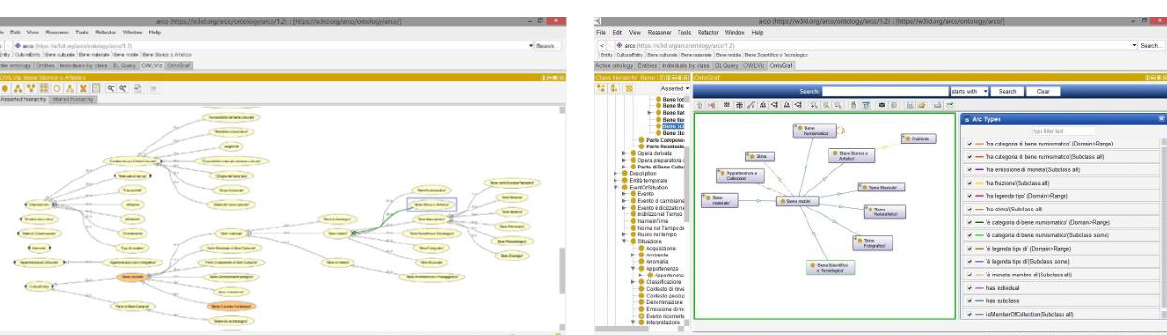
Figure 7. Protege ́ visualization and the relations among these classes.